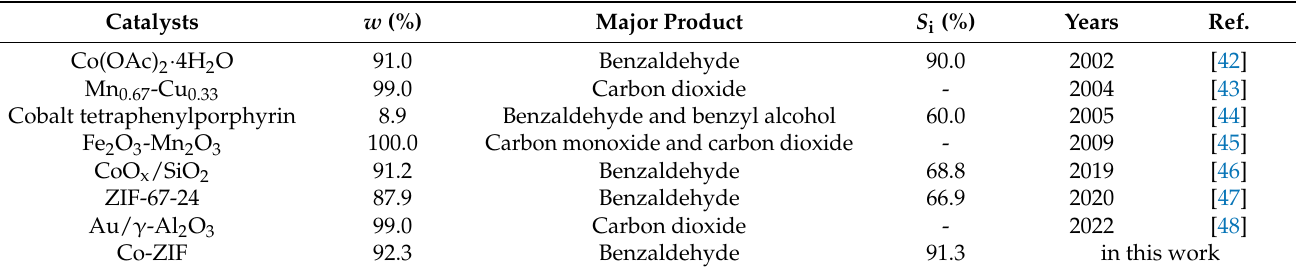
Table 3. Comparison of oxidation of toluene catalyzed by various catalysts.